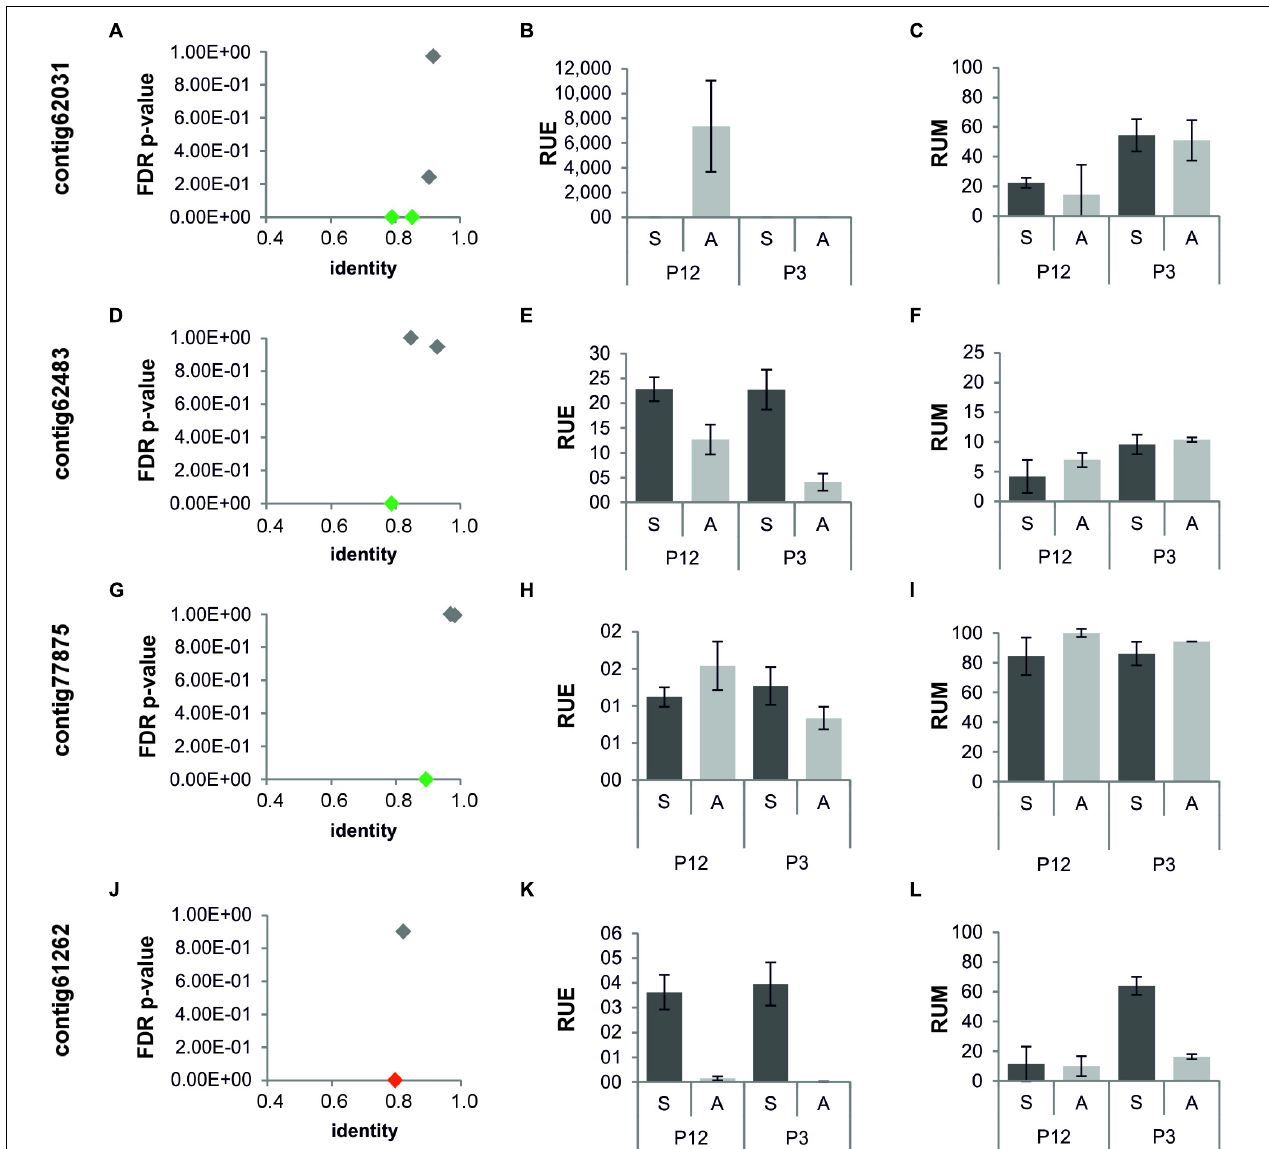
FIGURE 4 | Sequence conservation, expression, and CpG methylation patterns of loci encoding for TEs and characterized by the expression of multiple transcript variants. (A–C) Contig62031; (D–F) contig62483; (G–I) contig 77875; (J–L) contig61262; (A,D,G,J) sequence identity and FDR p -value are plotted in the x and y axes, respectively. (B,E,H,K) Quantitative Real-Time PCR results for DEGs annotated as TEs, co-mapping into the same loci. (C,F,I,L) Methylation levels estimated for the same loci. Green diamonds: DEGs up-regulated or displaying APO-specific expression. Red diamonds: DEGs down-regulated or displaying SEX-specific expression. Gray diamonds: transcripts displaying no transcriptional changes. Dark gray bars: gene expression and DNA methylation levels in sexual samples; light gray bars: gene expression and DNA methylation levels in aposporous samples. P12: pistils at stage 1 and 2 (pre-meiosis and meiosis). P3 pistils at stage 3 (early gametogenesis). RUE: relative units of expression. RUM: relative units of